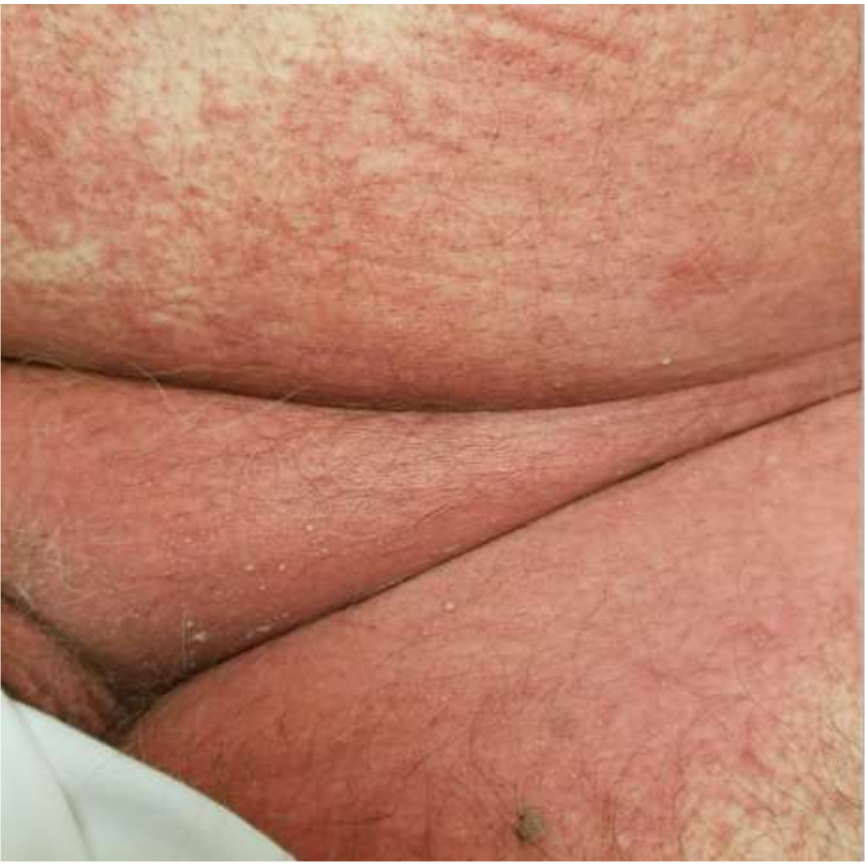
Figure 2. Acute generalized exanthematous pustulosis due to clindamycin. Early features include flexural erythema and small monomorphous